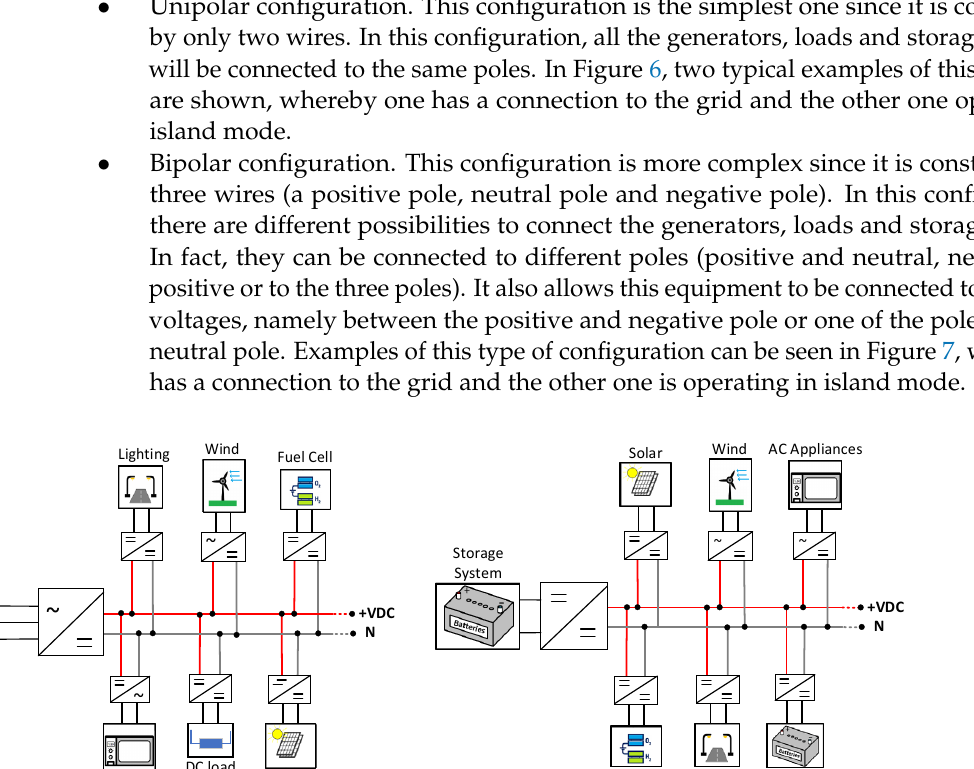
Table 1. Summary of the DC microgrid topologies and corresponding references. DC Structures